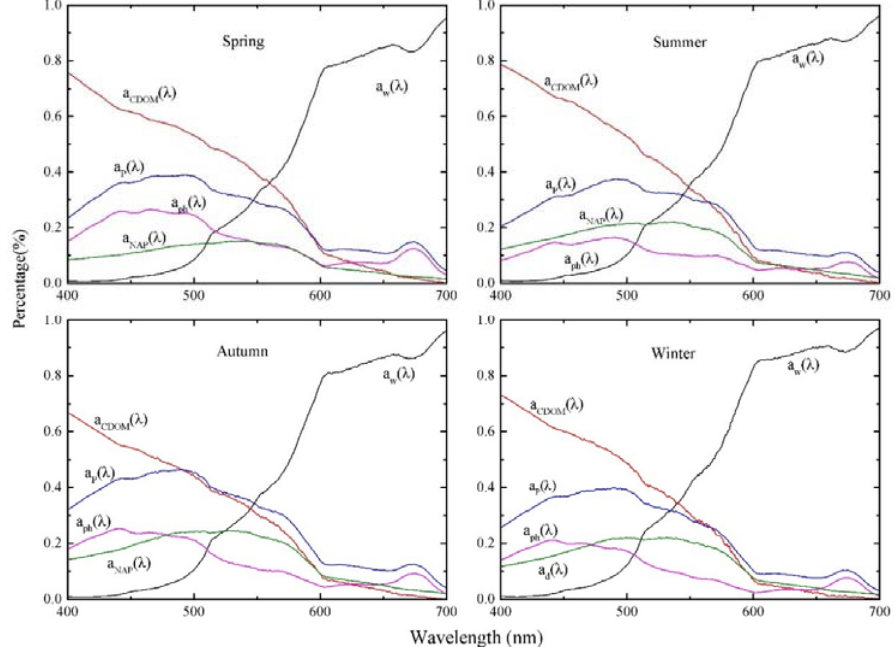
Figure 15. Fractional contribution of absorption coefficients of pure water [ a w ( λ ) ], CDOM [ a CDOM ( λ ) ], total particles [ a p ( λ ) ], phytoplankton [ a ph ( λ ) ], and NAP [ a NAP ( λ ) ] to the total absorption [ a t ( λ ) ] in the four seasons.